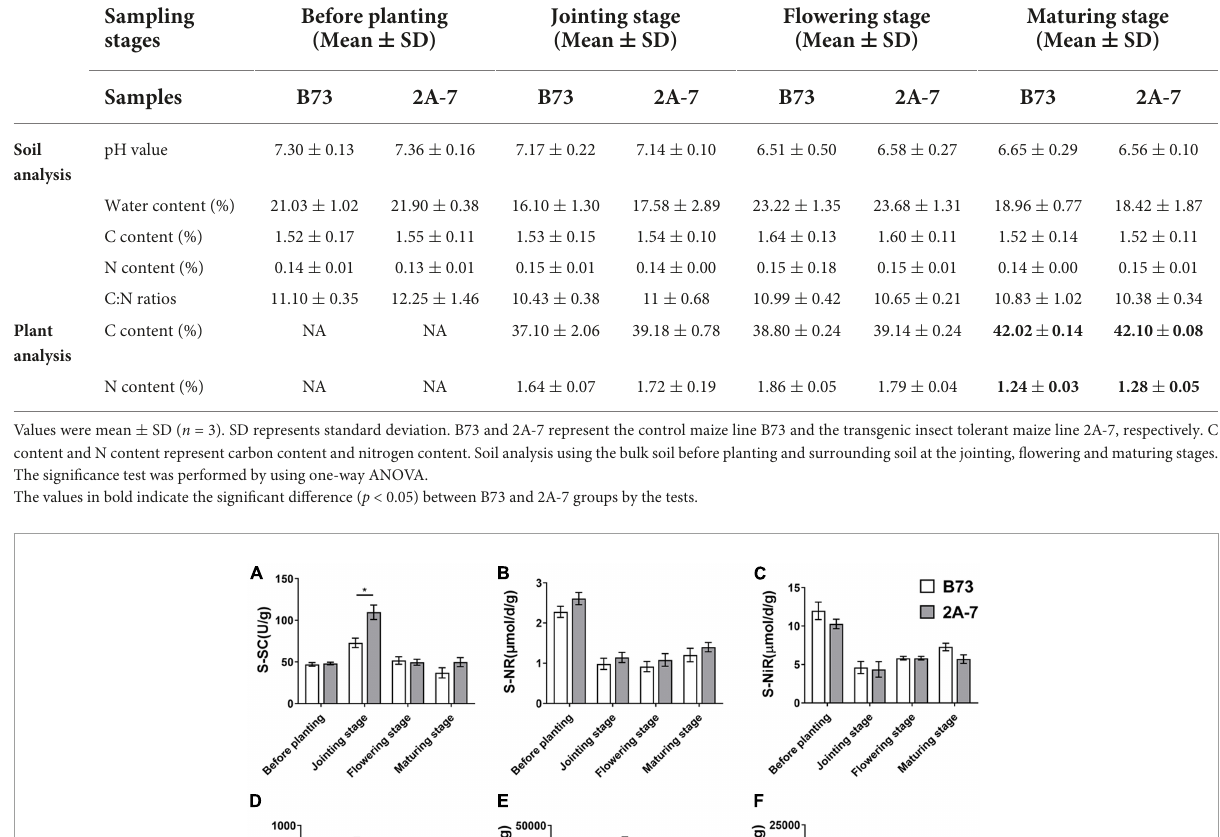
TABLE 1 Physicochemical properties of soil and